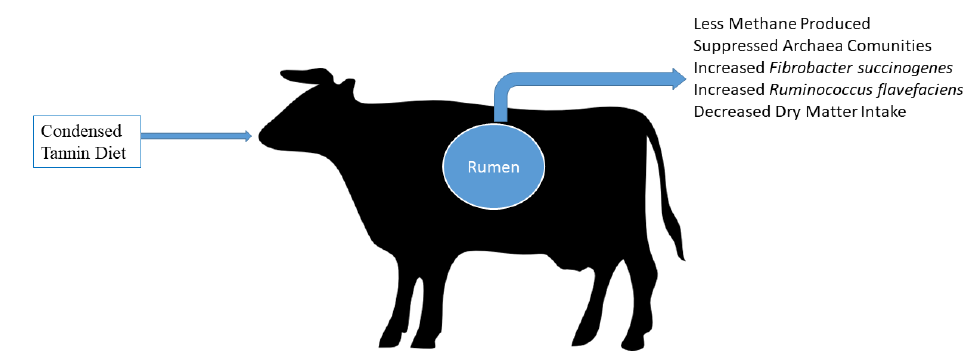
Figure 2. Main effects of dietary inclusion of condensed tannins .